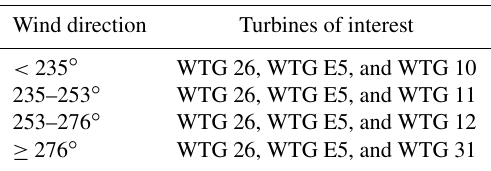
Table 2. Wind turbines of interest, scheduled according to the wind direction. To maximize the benefits of wake steering, only three tur- bines are considered at a time, depending on the ambient wind di-